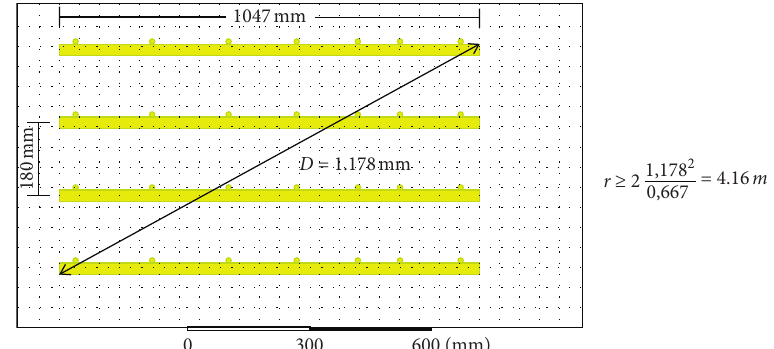
Figure 4: Calculation to define the distance required to avoid mutual